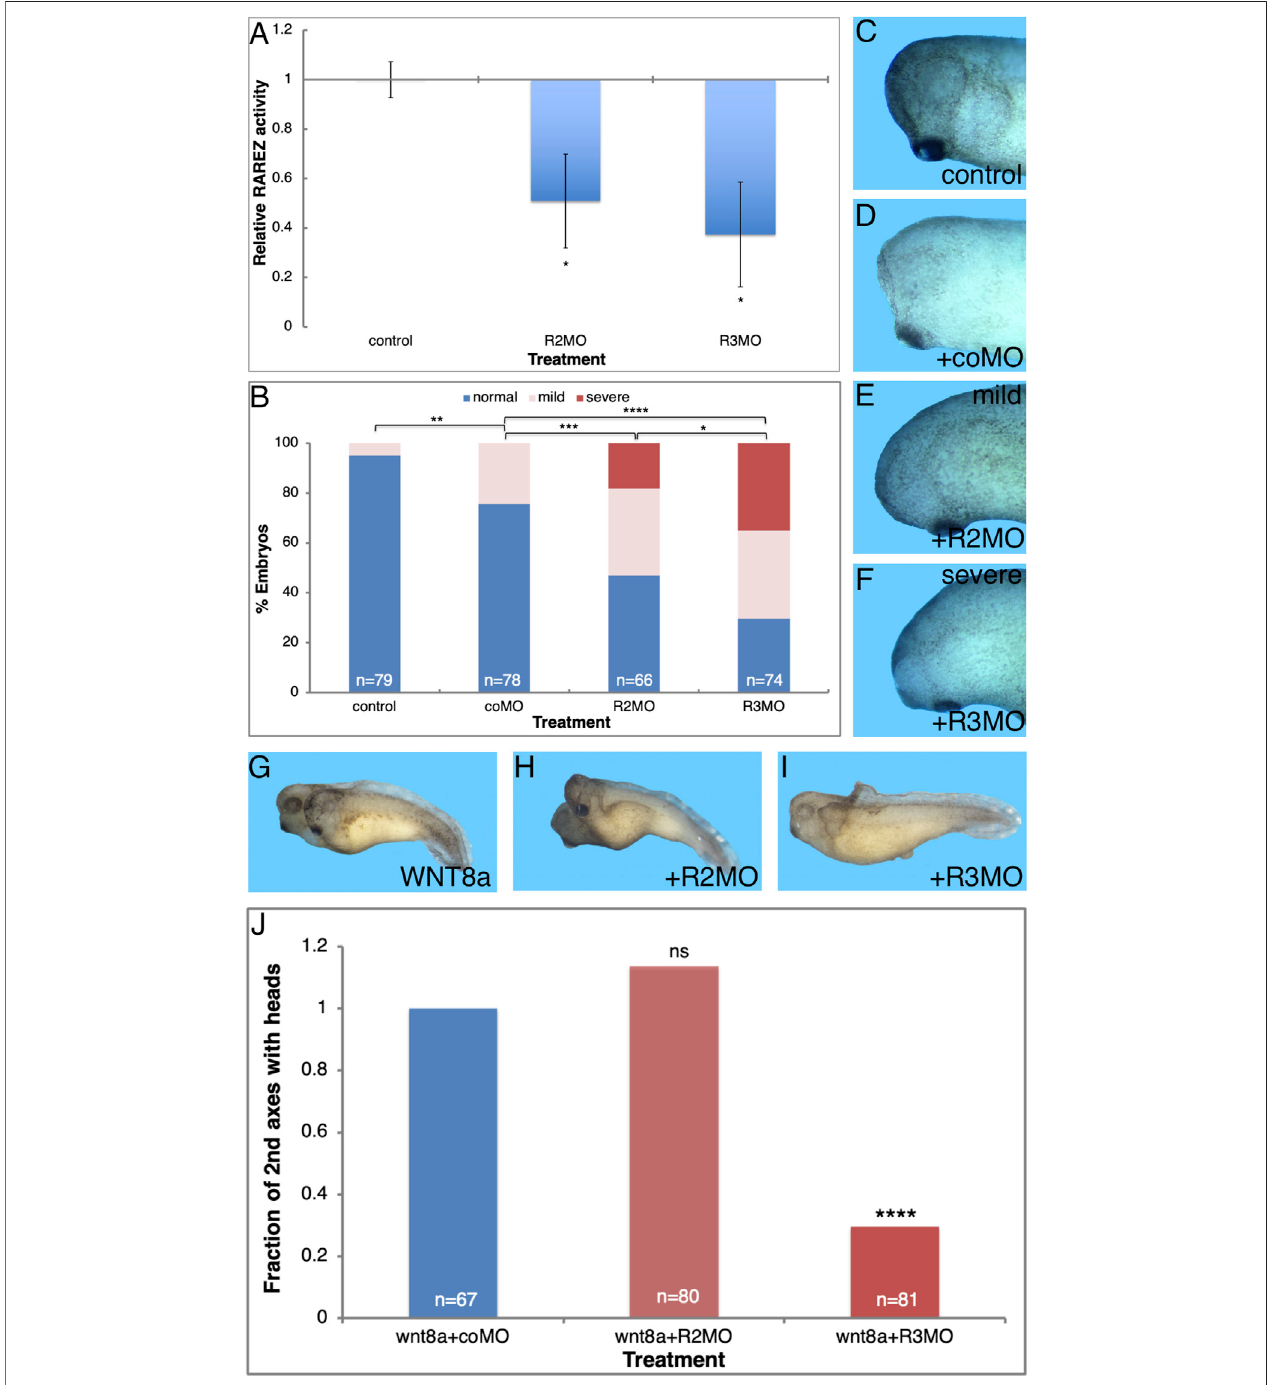
FIGURE5| ALDH1A3isnecessaryfornormalheaddevelopment.EmbryoswereinjectedwiththeR2MOorR3MOtoreducetheactivityofALDH1A2orALDH1A3, respectively. (A) Analysis of the effect on the RA signaling level by co-injection of the RA reporter plasmid and chemiluminescent analysis of the ß-galactosidase activity. (B – F) Embryos injected dorsally with the R2MO, R3MO, or coMO to induce ALDH1A2 or ALDH1A3 knockdown in the Spemann-Mangold organizer. Embryos were sensitized for changes in RA levels by co-injection of low, non-teratogenic, amounts of cyp26a1 RNA. The extent of microcephaly induction was quantitated (B) . Examples of head development for control uninjected (C) , coMO (D) , R2MO (E) , and R3MO (F) injected embryos are shown. (G – J) Analysis of head malformations in secondary axes induced by ventral injection of wnt8a RNA together with ALDH1A2 or ALDH1A3 knockdown. (G) Control embryo. (H) ALDH1A2 knockdown. (I) ALDH1A3 knockdown. (J) Quantitation of the effectof ALDH1A2 or ALDH1A3 knockdown on head developmentin the induced secondary axes. The overall number of embryos injected or manipulated is shown ( n =). *, p < 0.05 **, p < 0.01; ***, p < 0.001 ****, p < 0.0001; ns, not signi fi cant.